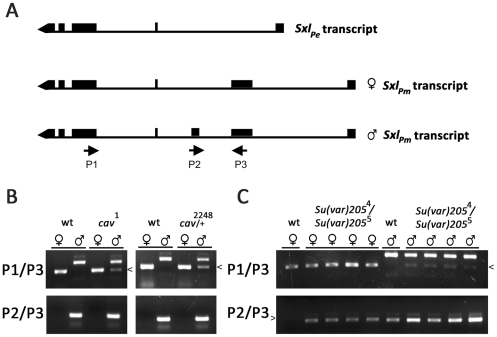
Aberrant sex-specific SxlPm-derived transcripts are observed in mutants for HOAP and in mutants for HP1.(A) RT-PCR was used to specifically amplify male- or female-specific SxlPm transcripts. The P1/P3 primer pair amplifies a 482 bp product from the female-specific transcript and a 672 bp product from the male-specific transcript in wild type animals (labeled wt in all three panels). The P2/P3 pair amplifies a 284 bp product from a male-specific transcript in males only. (B) Pools of RNA from individually sexed male or female cav
1 homozygous or cav
2248 heterozygous embryos failing to progress to the larval stage were used in RT-PCR assays with both P1/P3 (top panel) and P2/P3 (bottom panel) primer pairs, revealing the presence of aberrant female-specific SxlPm transcripts in male embryos (arrowhead). RT-PCR assays of RNA from four different individually sexed Su(var)205
4/Su(var)205
5 female (♀) or male (♂) larvae, each with both P1/P3 (top panel) and P2/P3 (bottom panel) primer pairs revealed the presence of aberrant sex-specific SxlPm transcripts in both sexes. The methods used to genotype and sex individual embryos and larvae are described in Materials and Methods.